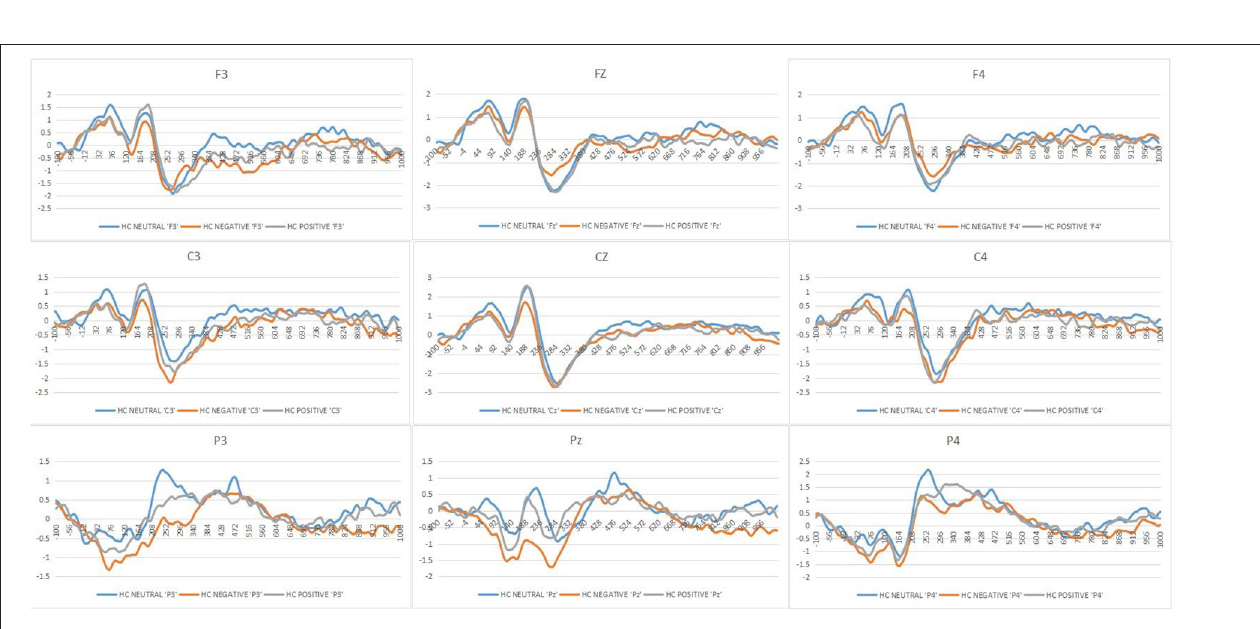
FIGURE 2 | Grand mean ERPs in each affective stimuli and neutral stimuli at the nine ERPs electrodes with time window of P200 for healthy controls (HCs or Healthy controls, Neutral or neutral stimuli, Negative or negative stimuli, Positive or positive stimuli).